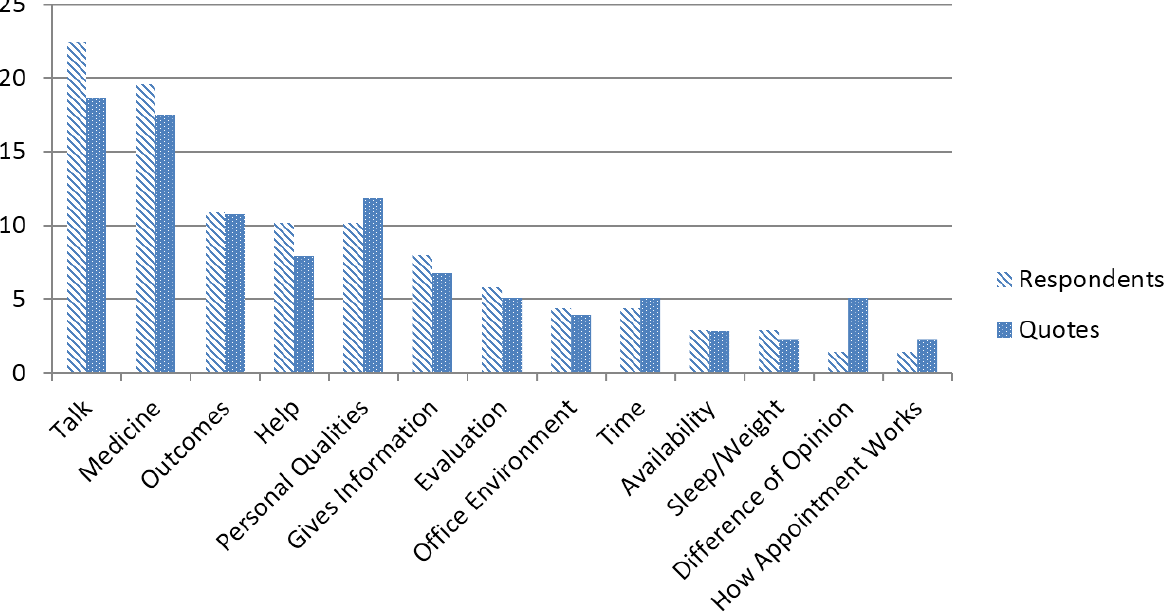
Figure 1. All value themes: percent of total respondents versus percent of total